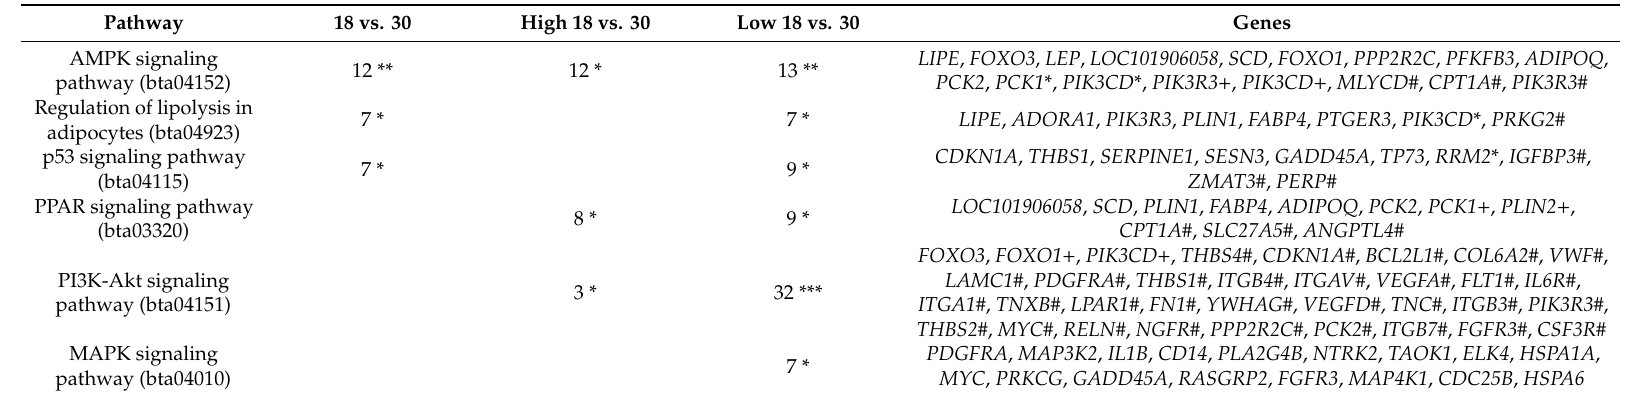
Table 3. Enrichment analysis of the pathways related to fat deposition and growth in Hanwoo. Statistical significance represented by the adjusted p -value: * p < 0.05;